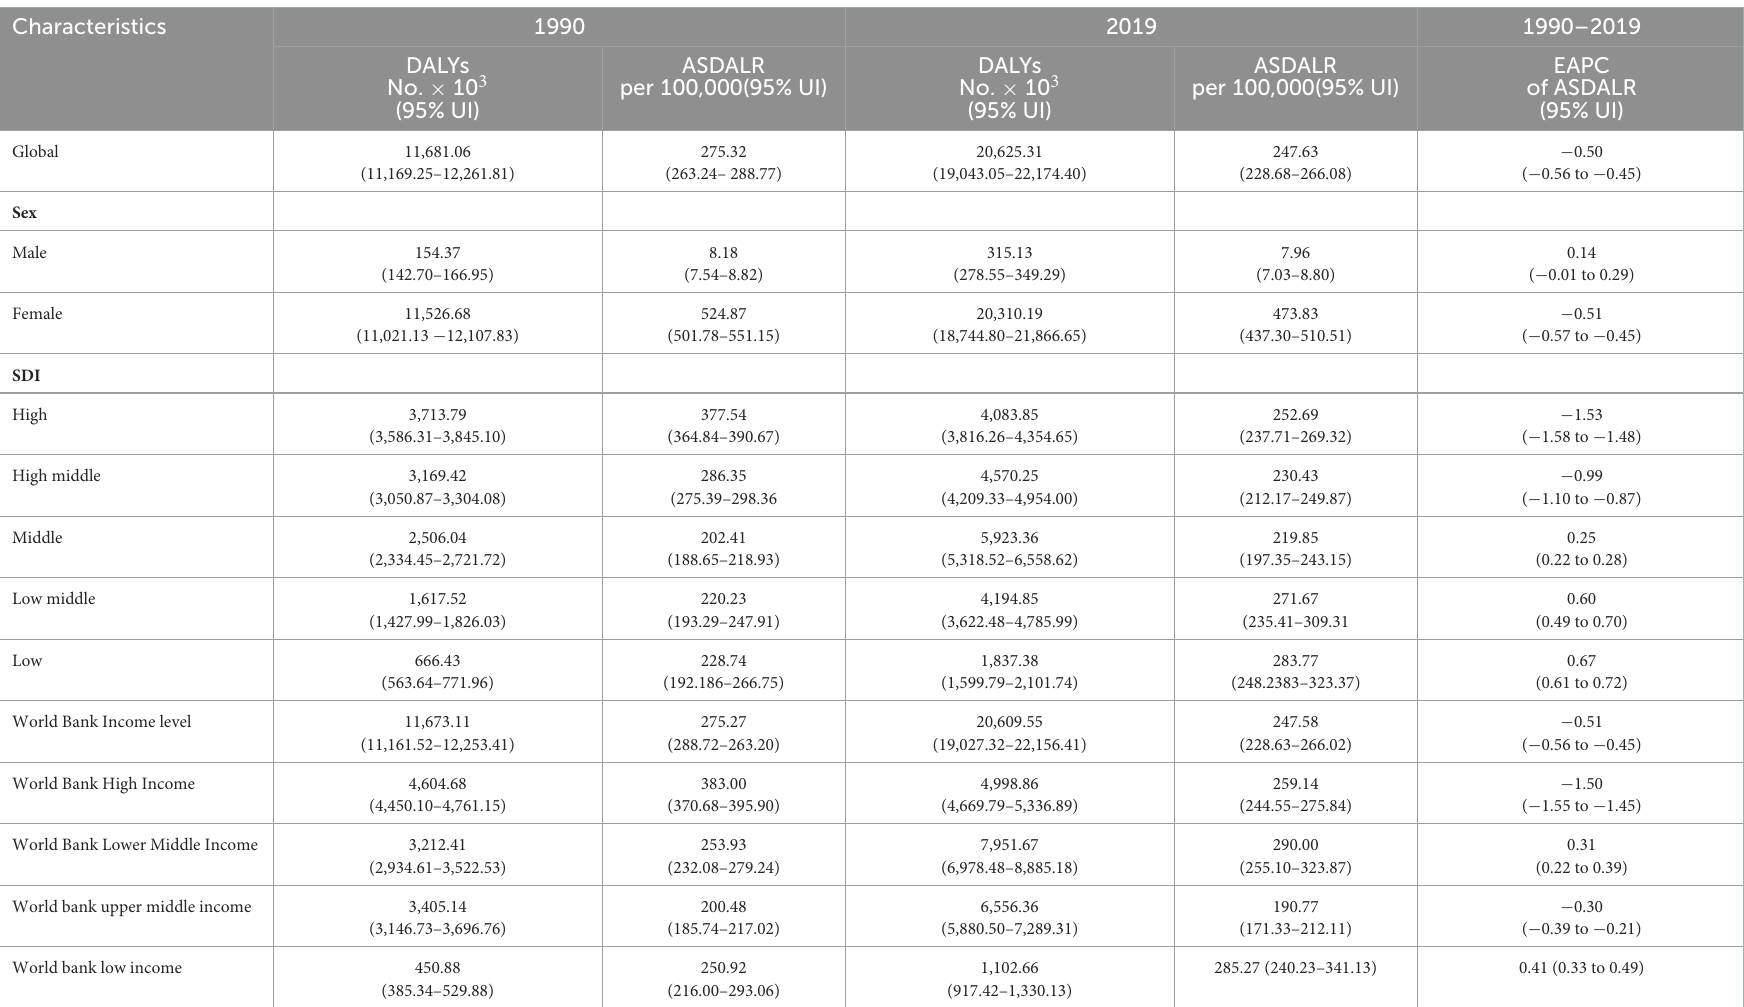
TABLE 2 The case numbers of disability-adjusted life years and age-standardized rates disability-adjusted life years of breast cancer in 1990 and 2019, and its temporal trends from 1990 to 2019.